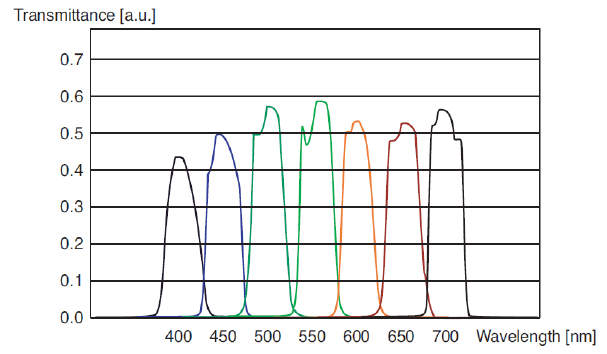
Figure 12. Filter characteristics.